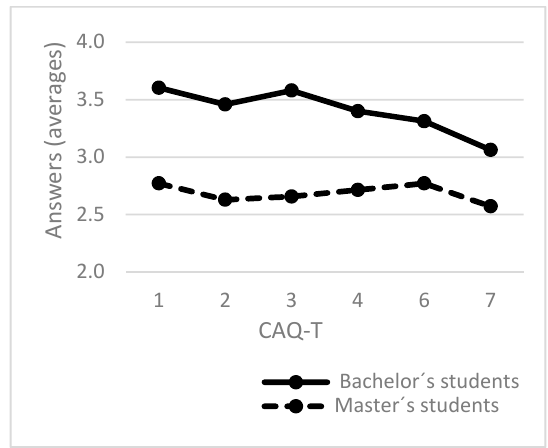
Figure 6. Answers of undergraduate and graduate students in CAQ-T.